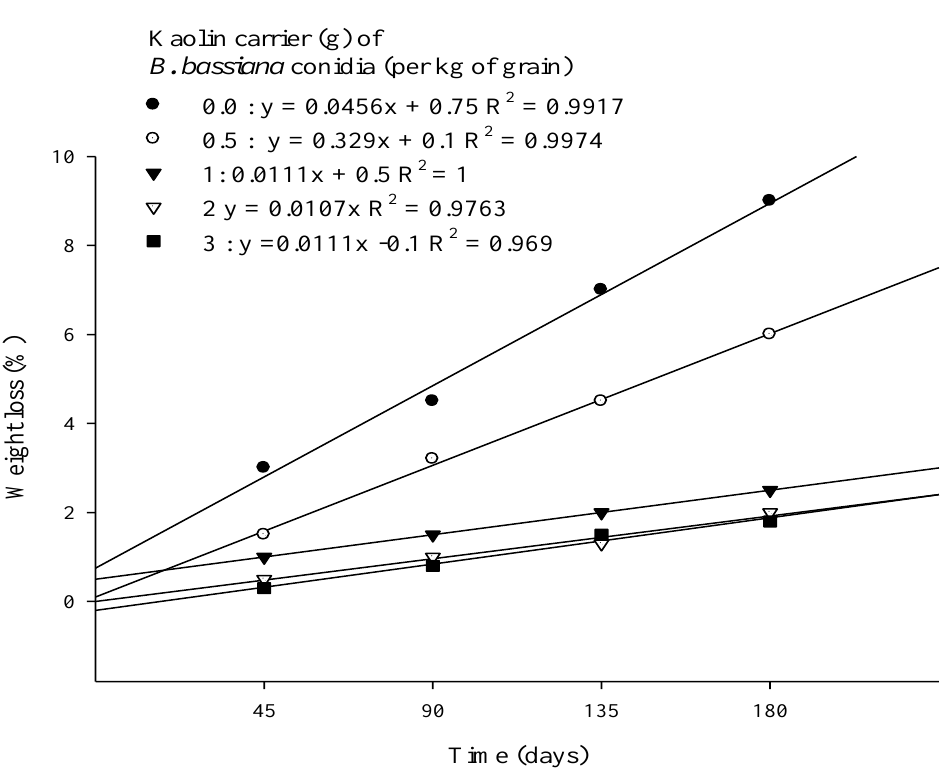
Figure 5. Grain weight loss over 180 days of Ephestia cautella larvae infestation of rice grains following treatments with Beauveria bassiana Strain MS-8 at 0.03 g conidia kg − 1 of grain formulated in various doses of kaolin. Table 1. Correlation coefficients between the measured secondary parameters and mortality of in- sects.